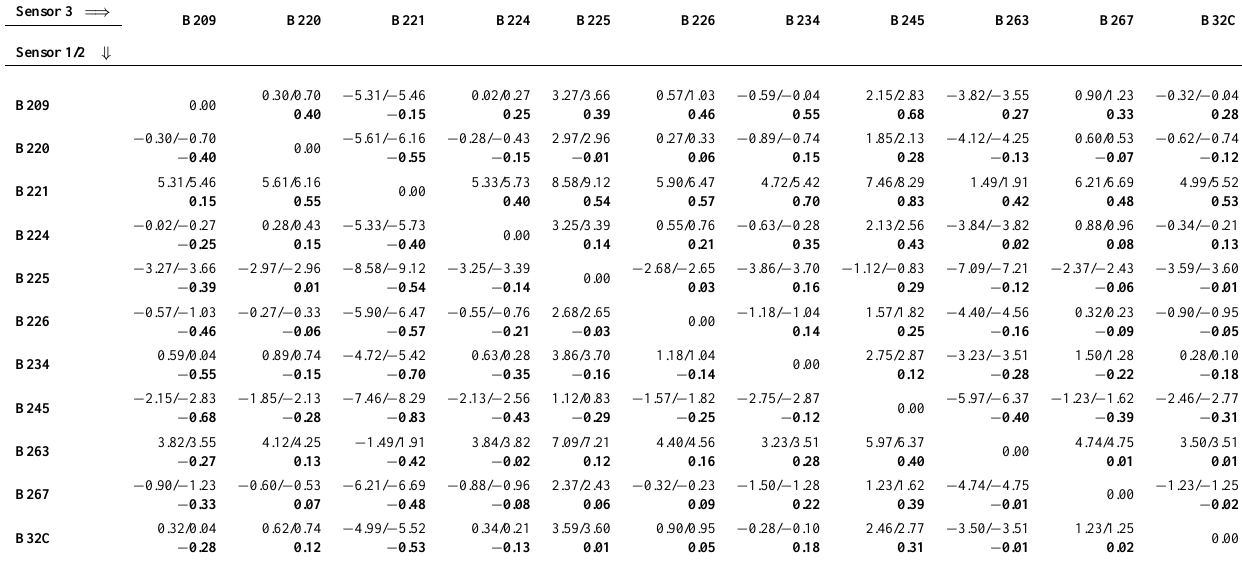
Table A1. Table listing the optimal angles of rotation ( % N / % E ) found to best align the horizontal components of 11 RefTek 151-60A sensors. Differences of the angles of rotations ( % E − % N ) are listed boldfaced below them. From these, the best assumable error in orthogonality between N/S- and E/W-components is ( % E − % N